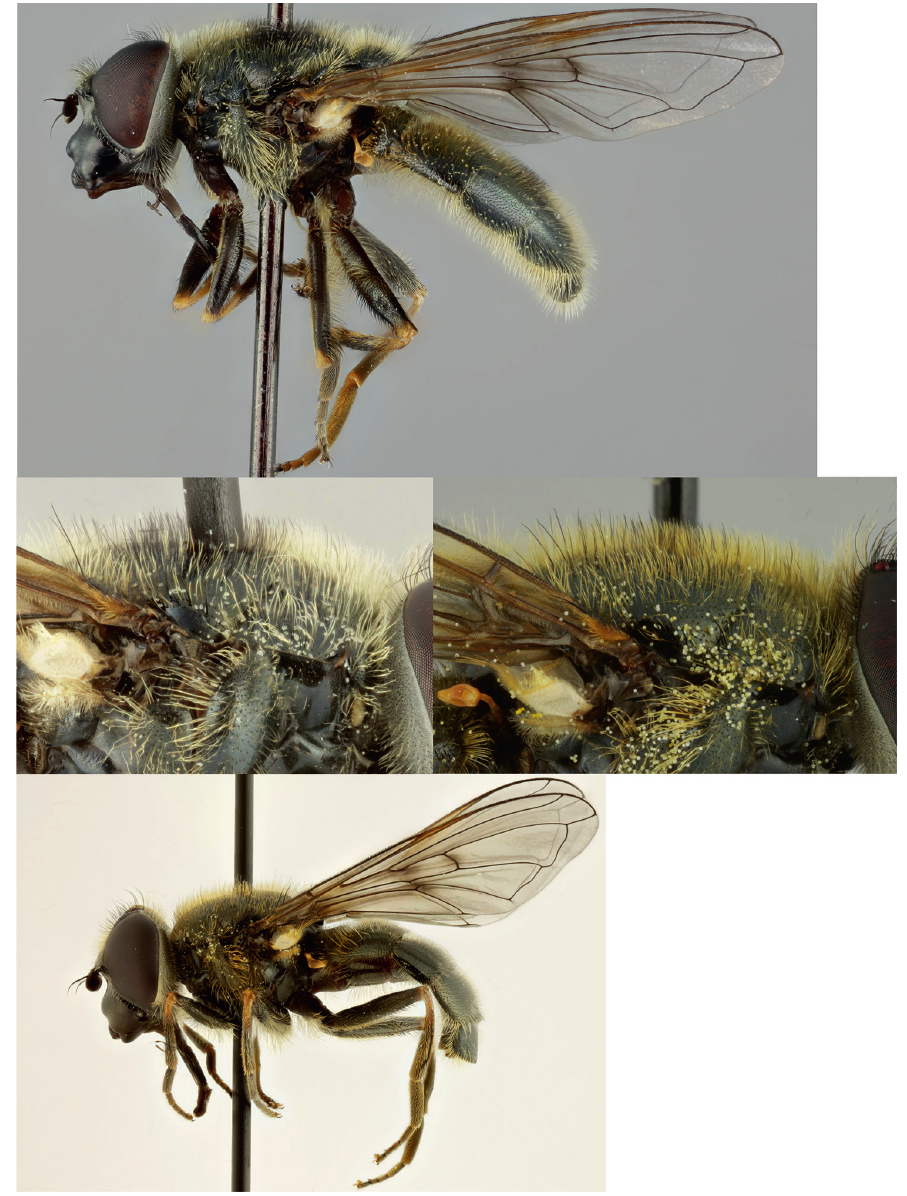
Figure 4. Cheilosia caerulescens caerulescens (Meigen). A Male, lateral view B, C Thorax of male lateral view, variability of composition of pilosity on scutum D Female, lateral